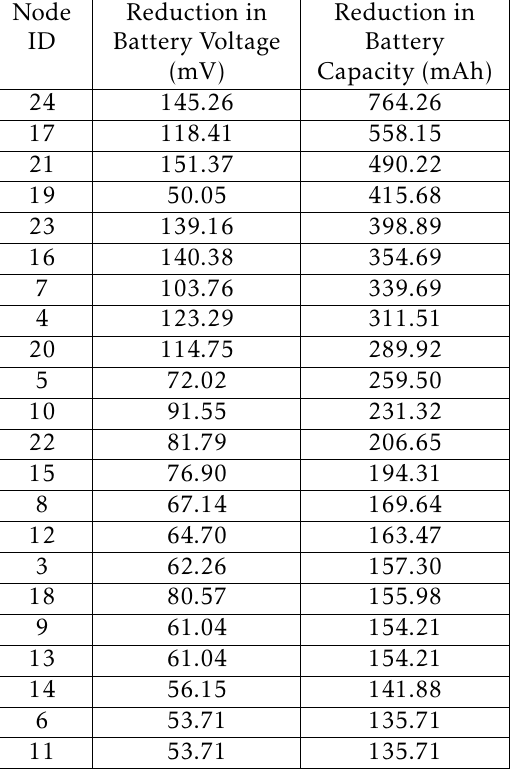
Figure 22. Energy expenditure for data collection round 1 in test case 1 Table 3. Decreasing order of energy